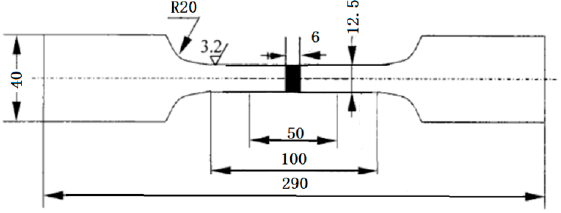
Figure 2. Recorded thermal cycle curves in welding and the local zone conditions.